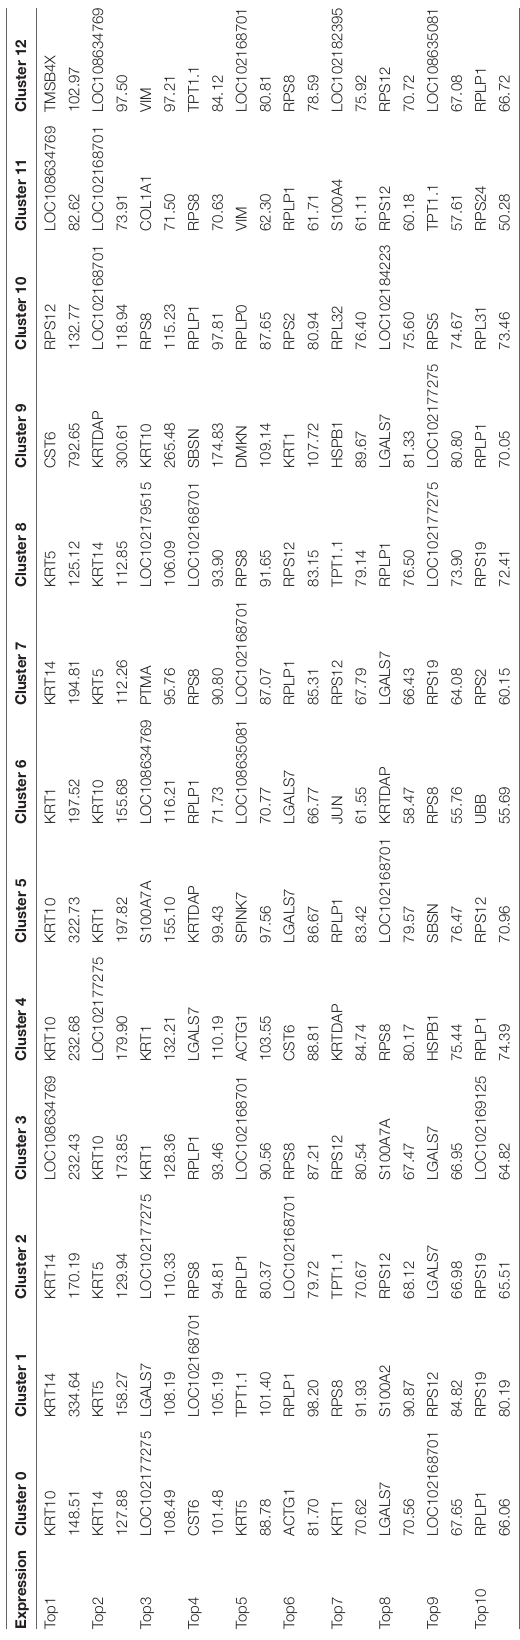
Figure 4 . In the gene networks, some hub genes interacted